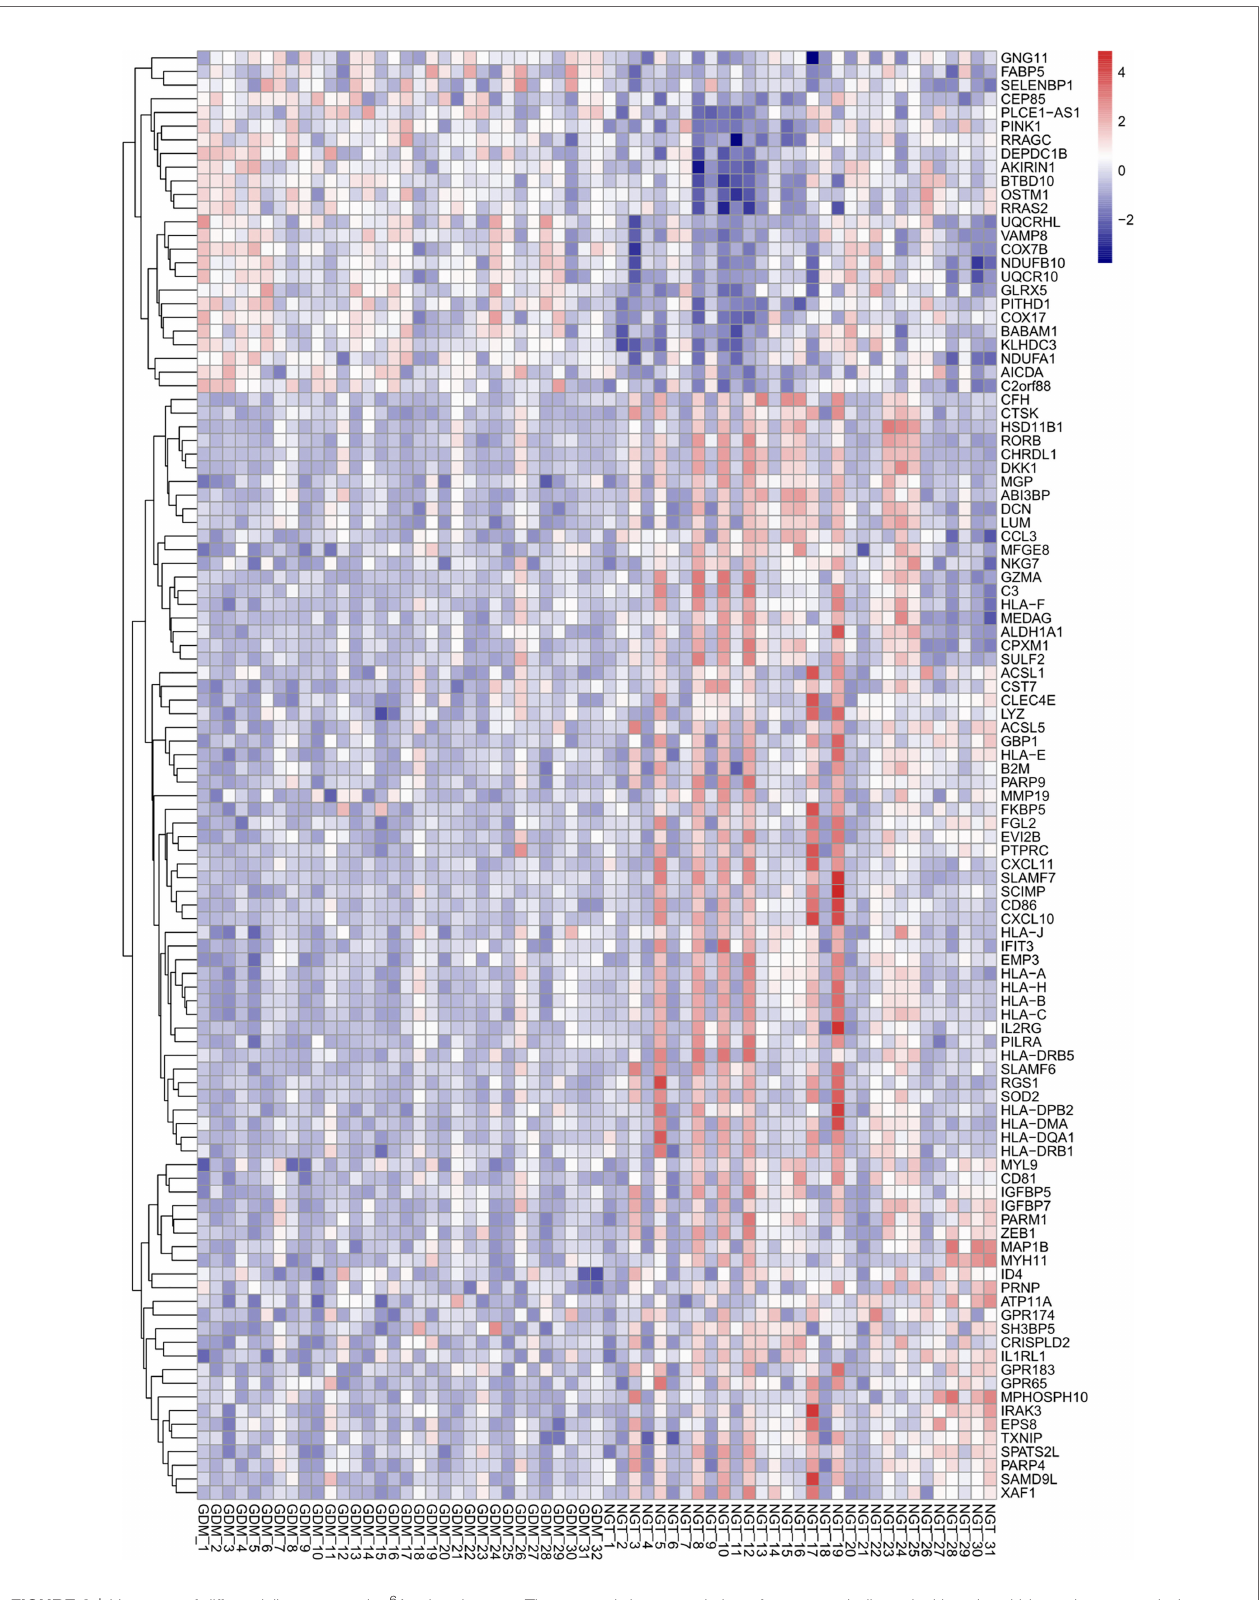
FIGURE 2 | Heatmap of differentially expressed m 6 A-related genes. The up- and down-regulation of genes are indicated with red and blue color,